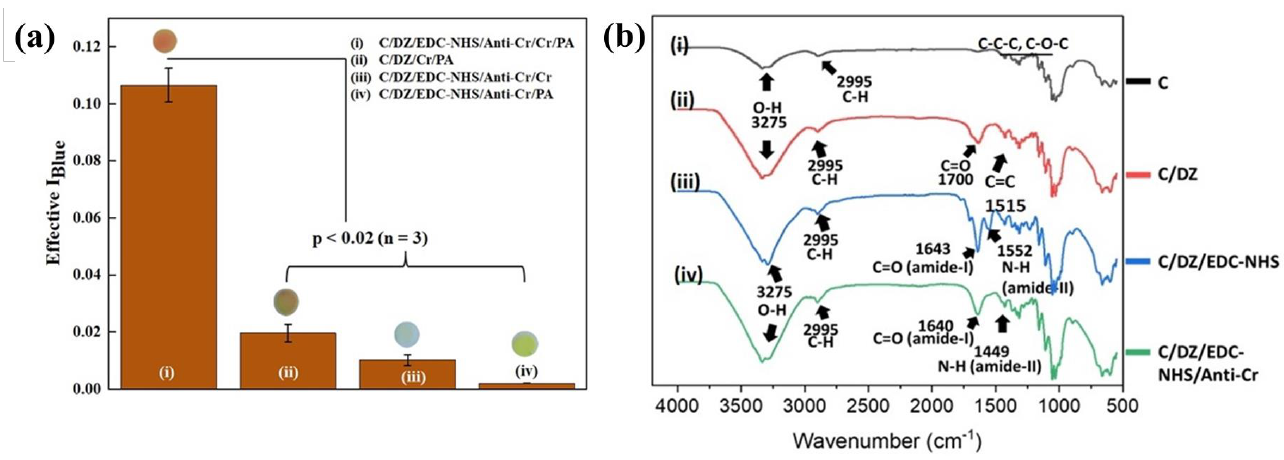
Figure 3. ( a ) Histograms showing the comparative Effective I Blue of the different sensing probes: (i) C/DZ/EDC – NHS/anti –